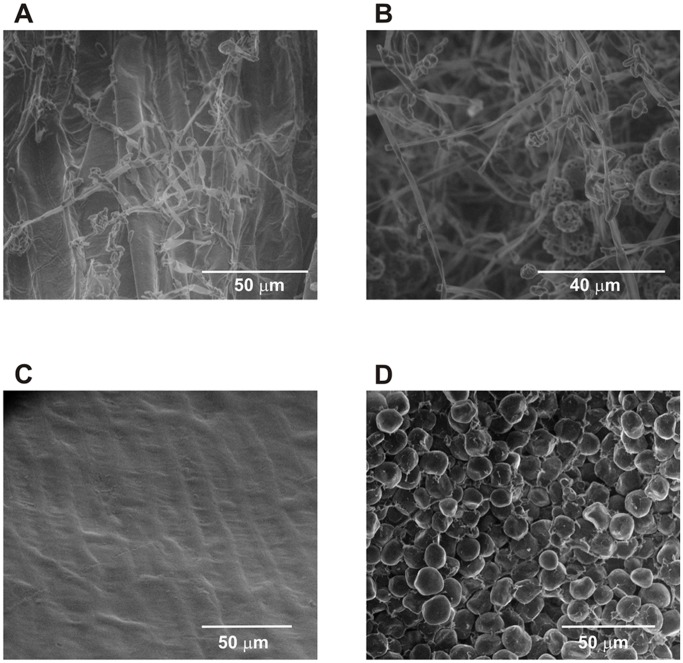
Scanning electron micrographs of Fusarium verticillioides inoculated maize kernels of L4637 (resistant) and L4674 (susceptible) inbreds.Hyphae growing at the pericarp surface (A) and endosperm (B) in susceptible inbred. Absence of external (C) and internal (D) fungal infection in the resistant inbred.